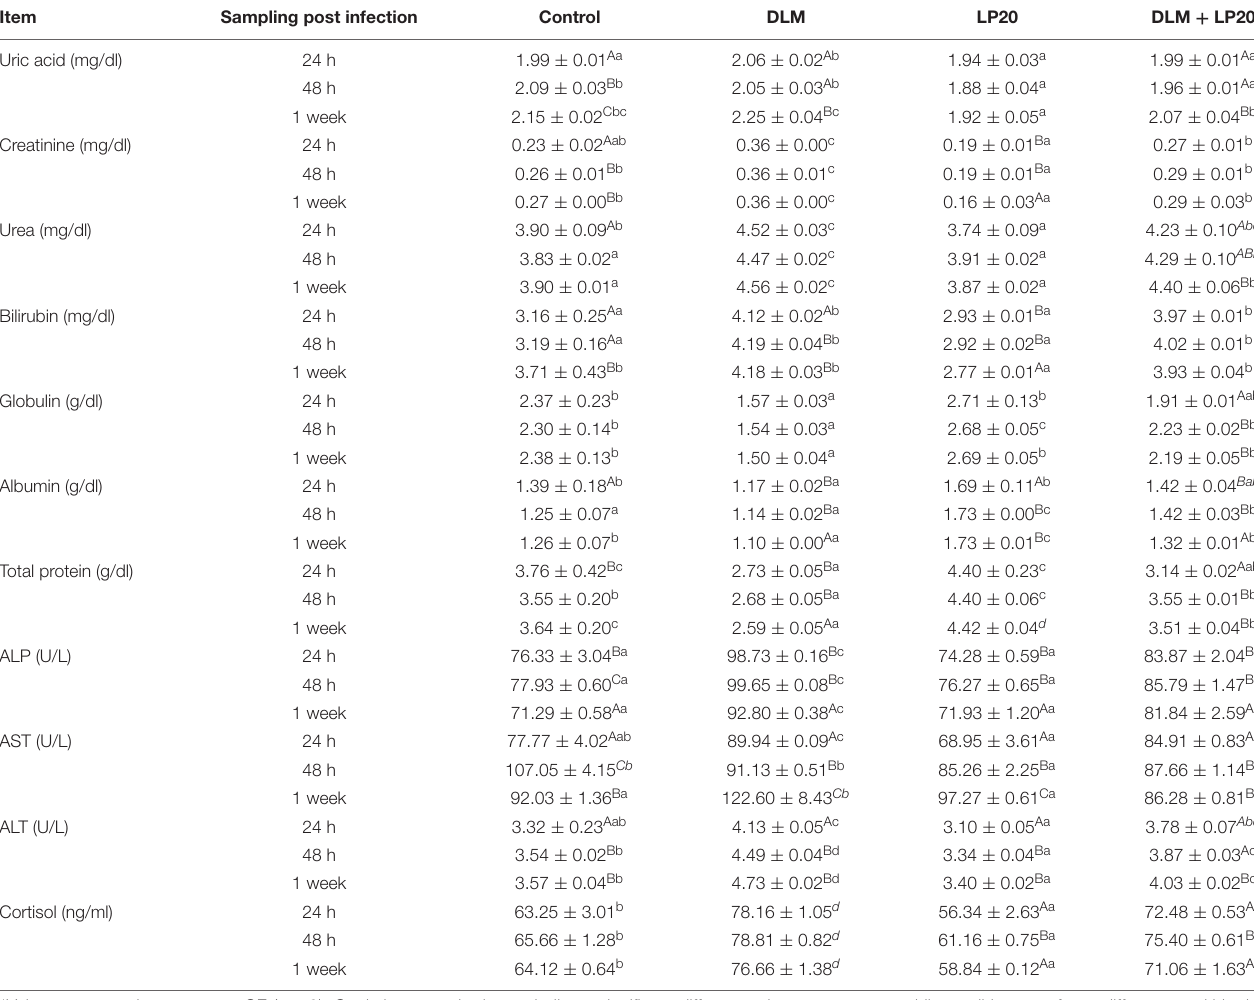
TABLE 3 | Blood biochemical parameters of Nile tilapia exposed to deltamethrin (DLM) and challenged with Aeromonas hydrophila and fed diets with or without LP20 for 30 days. Item Sampling post